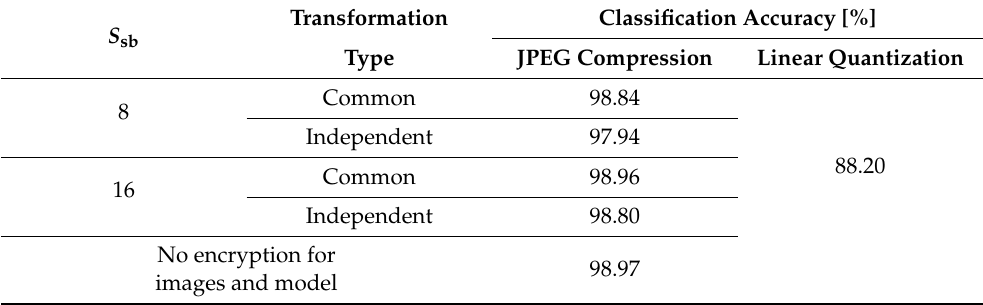
Table 3. Classification accuracy for scheme B ( Q = 85).